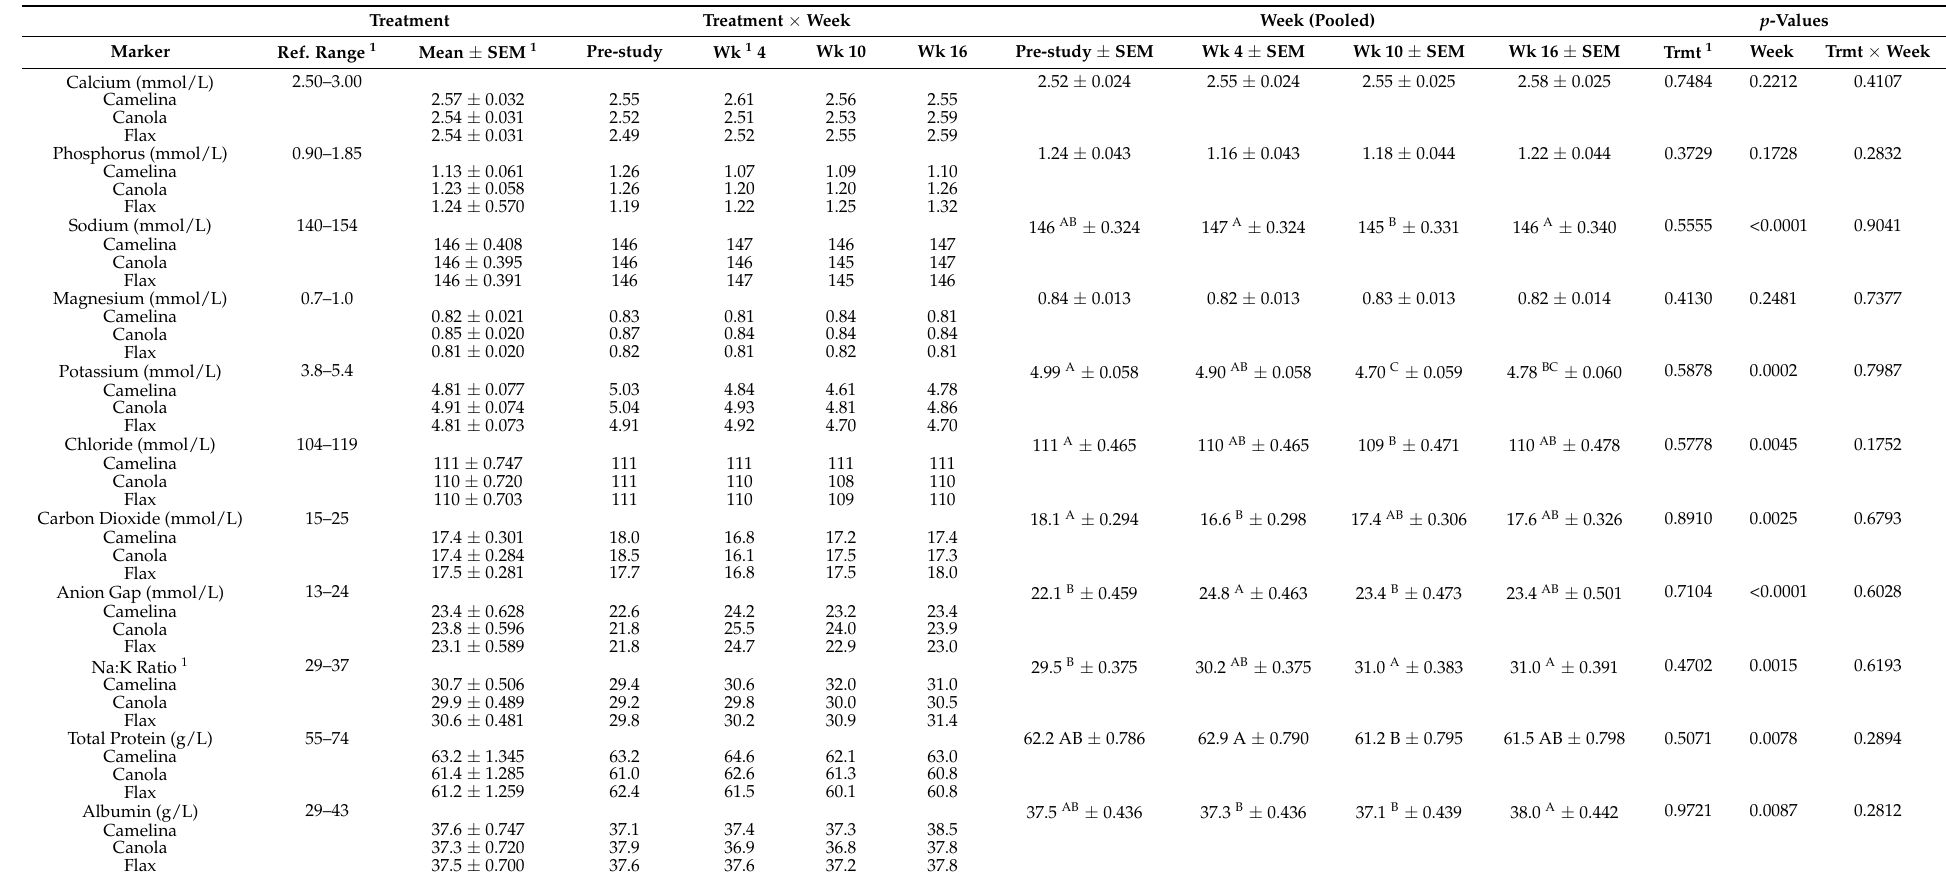
Table 5. Serum biochemistry for healthy, adult dogs fed one of three dietary oil supplements (camelina, flax, or canola oil) over a 16-week period. Values are shown are lsmeans estimates for treatment (oil), treatment by week interaction, and week. Treatment Treatment × Week Week (Pooled) p -Values